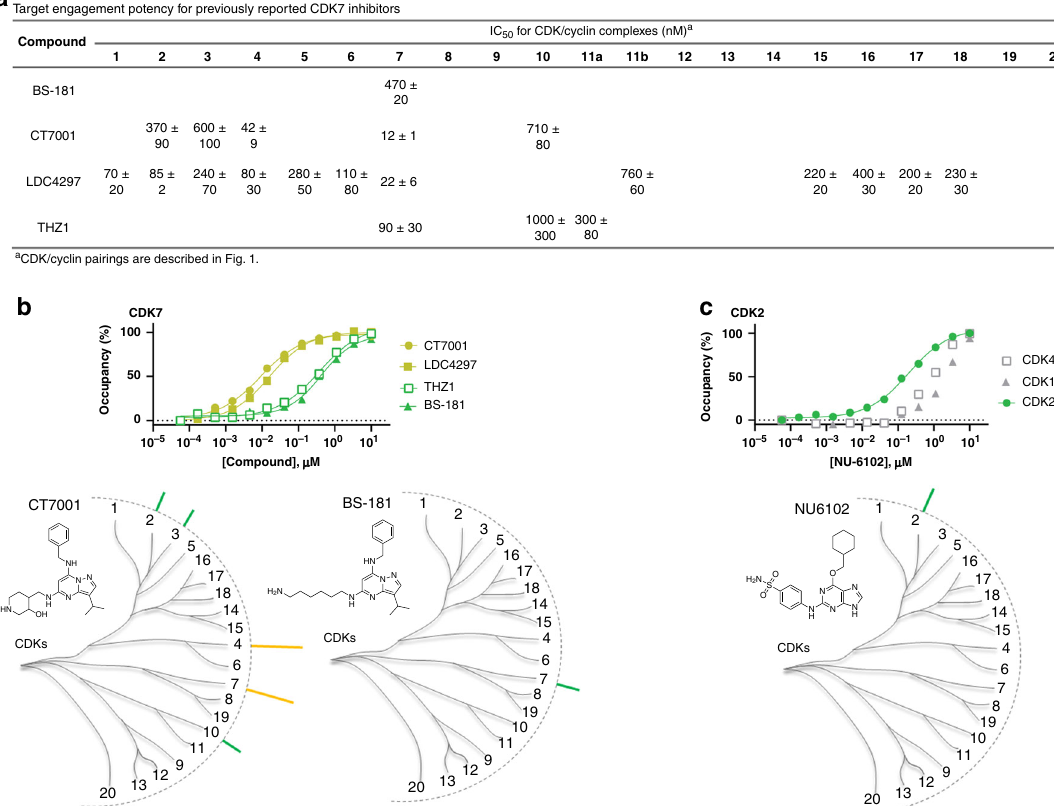
Fig. 3 Selective CDK7 and CDK2 inhibitors. a Live cell engagement potency for CDK7 selective probes. Reported IC 50 data are the mean of 3 independent experiments±S.E.M. (Supplementary Data 2). Blank cells represent IC 50 values that failed to meet our criteria of potency (<1 µ M) or occupancy ( ≥ 50% at 10 µ M). b Upper: Target engagement of CDK7-selective inhibitors. A representative single technical replicate ( n = 1) of live cell target occupancy results from 3 independent experiments (Supplementary Data 2). Lower: Compound structures and dendrogram-based illustration of engagement selectivity for CT7001 and BS-181 against the complete CDK family. c Upper: Target engagement of NU6102 against CDK2. A representative technical replicate ( n = 1) of target occupancy results from 3 independent experiments is shown (Supplementary Data 2). Potency of putative targets CDK1 and CDK4 are shown for comparison. Lower: Chemical structure and dendrogram-based illustration of engagement selectivity for NU6102. Source data are provided as a Source Data fi